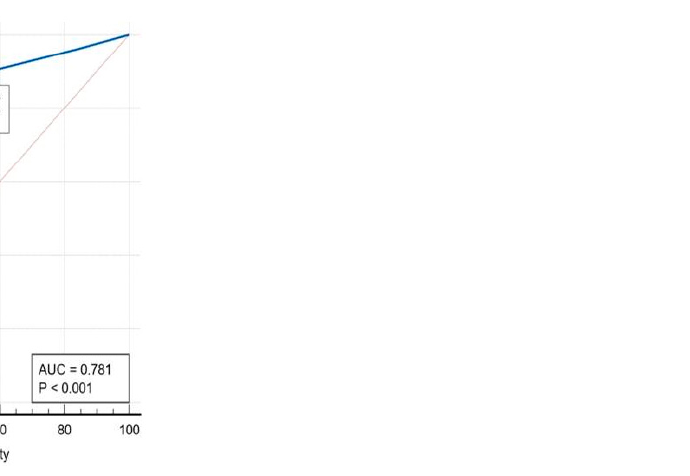
Figure 3. ROC curve—discrimination accuracy of the mortality prediction of the AFC/OCC score.